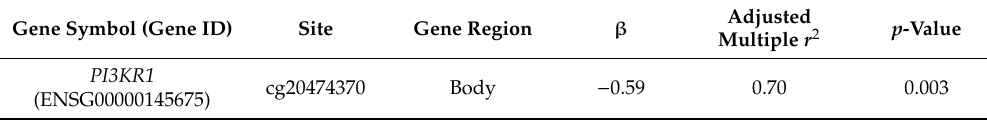
Table 3. Multiple linear regression showing the contribution of cg20474370 in gene expression . 122